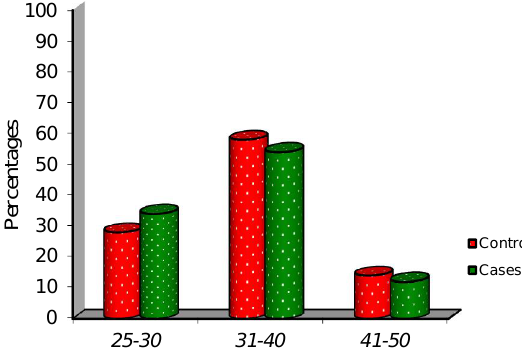
Figure 1: Age distribution of subject studied